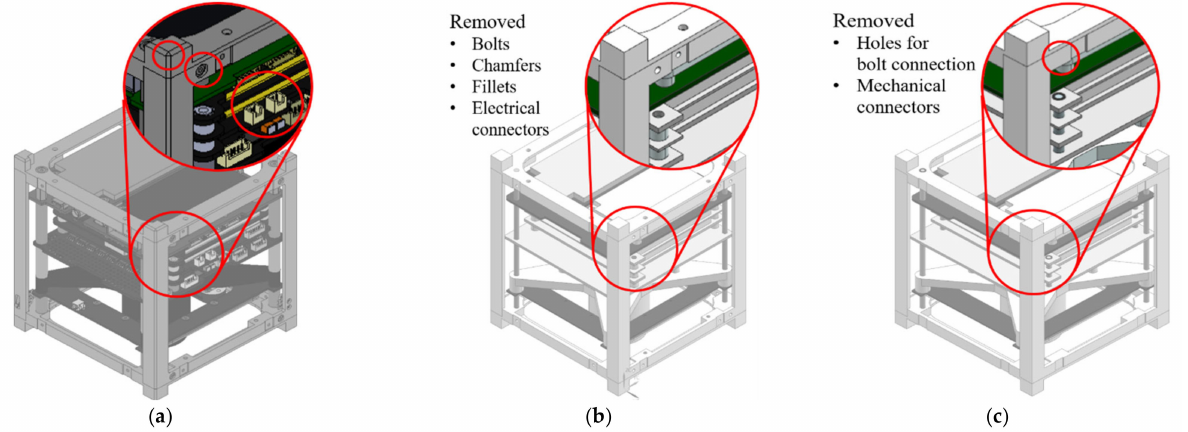
Figure 3. CAD and analytical models: ( a ) Detailed CAD model and ( b ) structural and ( c ) thermal analytical models of